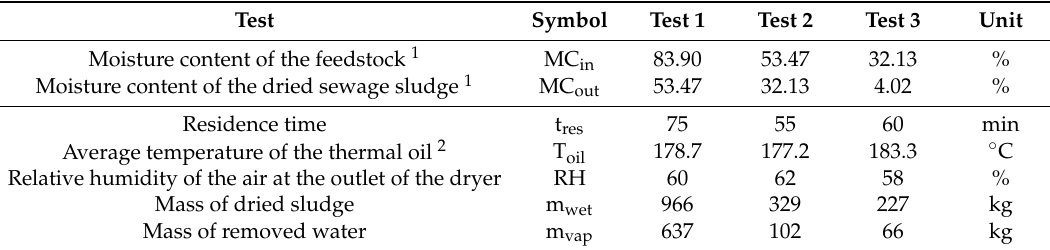
Table 2. Results of the drying tests, performed with commercial scale paddle dryer. Test Symbol Test 1 Test 2 Test 3 Unit Moisture content of the feedstock 1 MC in 83.90 53.47 32.13 % Moisture content of the dried sewage sludge 1 MC out 53.47 32.13 4.02 % Residence time t res 75 55 60 min Average temperature of the thermal oil 2 T oil 178.7 177.2 183.3 ◦ C RH 60 62 58 % Mass of dried sludge m wet 966 329 227 kg Mass of removed water m vap 637 102 66 kg 1 Wet basis; 2 Inside of the